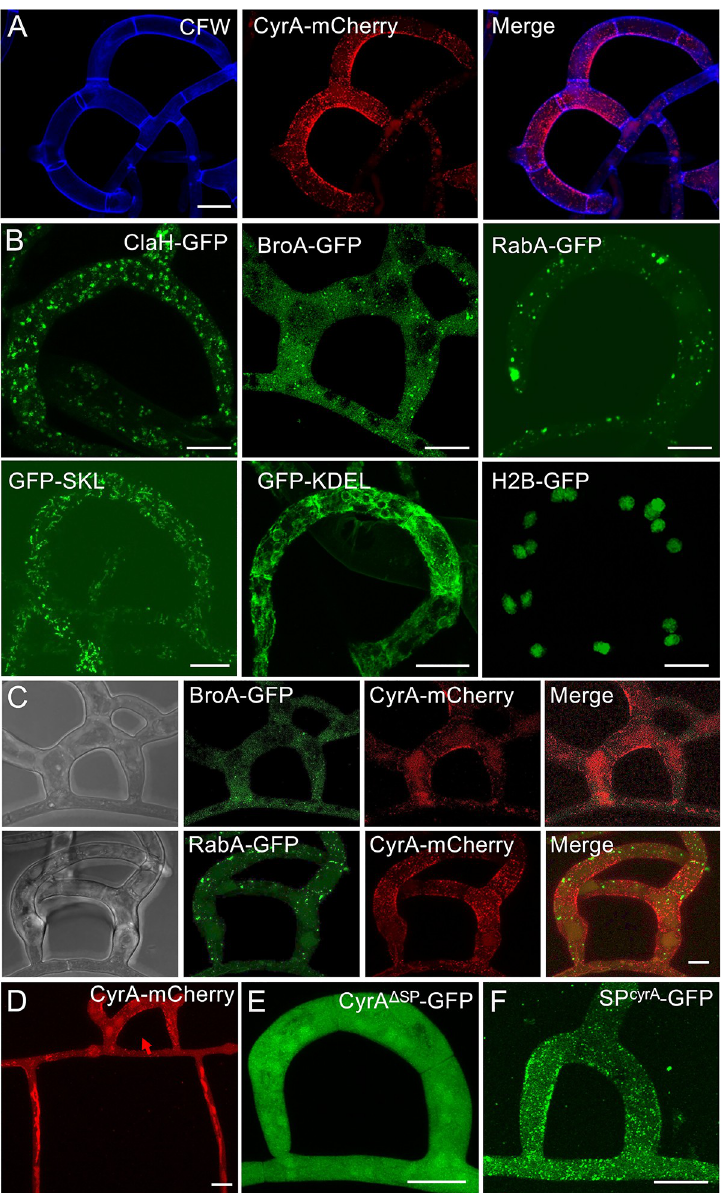
Fig 2. Localization of CyrA and different vesicles and organelles in traps of D . flagrans . (A) The CyrA-mCherry expressing strain sNH25 was co-incubated with C . elegans on LNA slides for 24 h at 28˚C to induce traps. The cell wall was stained with calcofluor white (CFW). (B) Visualization of vesicles and organelles through GFP fusion proteins. Clathrin coated vesicles (ClaH-GFP, strain sNH66), exosomes (BroA-GFP, sNH52), endosomes (RabA-GFP, sNH29), peroxisomes (GFP-SKL, sNH16), the ER (GFP-KDEL, sNH22) and nuclei (H2B-mCherry, sNH14). Scale bars = 10 μ m. (C) BroA-GFP and RabA-GFP, respectively, were expressed in the CyrA-mCherry expressing strain. Scale bars = 10 μ m. (D) cyrA-mCherry was expressed under the constitutive oliC -promoter (sNH25) but the localization of the fusion protein in speckles was only apparent in traps (arrow). In the surrounding vegetative mycelium, CyrA-mCherry localized in vacuolar structures. (E) CyrA was expressed without its signal peptide sequence fused to GFP (strain sNH41). (F) The 21 amino acid long signal peptide of CyrA was fused to GFP (strain sNH42) and the construct was expressed under the constitutive oliC